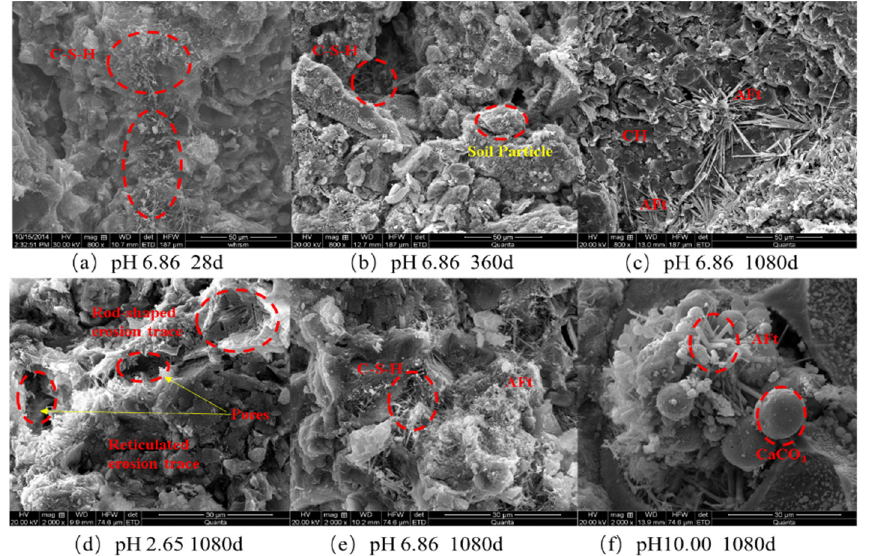
Figure 6. SEM images of S/S samples in the simulated scenarios: ( a ) S/S product soaked in pH 6.86 leachant for 28 d; ( b ) S/S product soaked in pH 6.86 leachant for 360 d; ( c ) S/S product soaked in pH 6.86 leachant for 1080 d; ( d ) S/S product soaked in pH 2.65 leachant for 1080 d; ( e ) S/S product soaked in pH 6.86 leachant for 1080 d; ( f ) S/S product soaked in pH 10.00 leachant for 1080